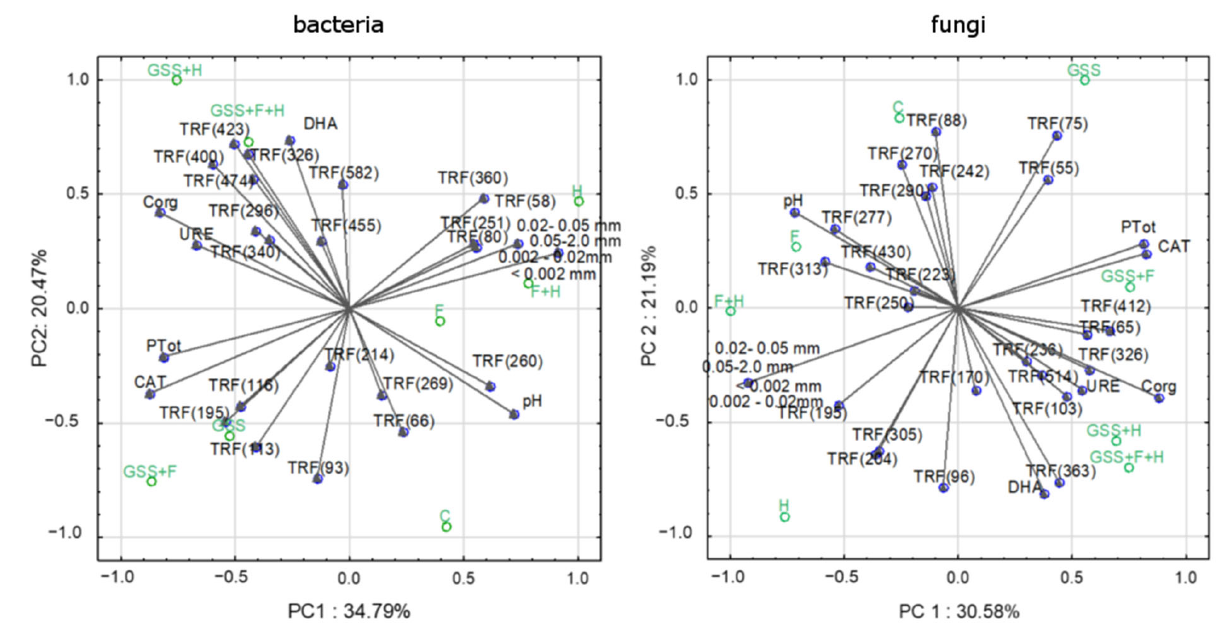
Figure 4. PCA analysis presented as BiPlot. Factor coordinates of cases represent the analyzed prop ‐ erties of soil and TRFs defined for bacterial and fungal community; factor coordinates of variables represent the research variants.